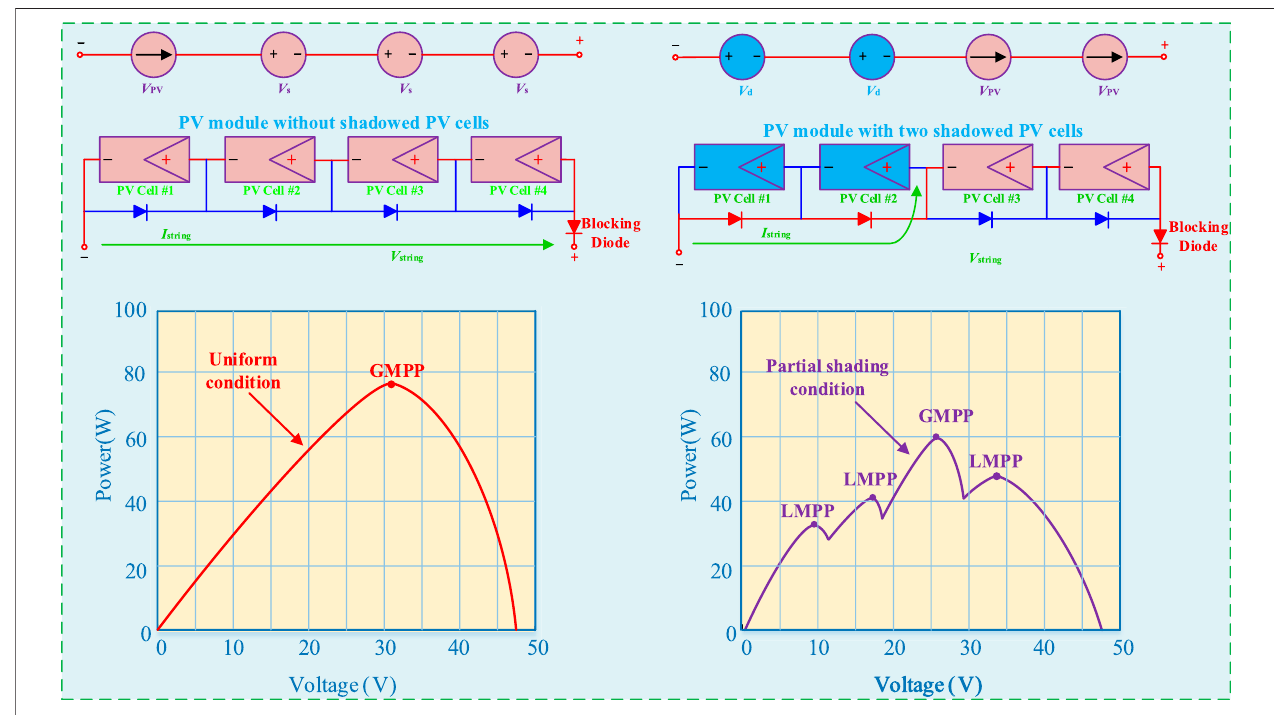
FIGURE 1 | P - V characteristic curves of PV